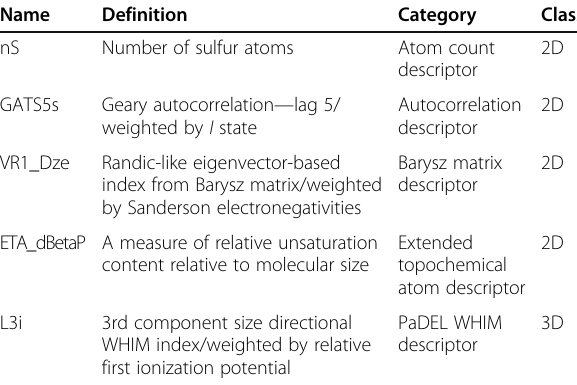
Table 3 Name, definition, category and class of molecular